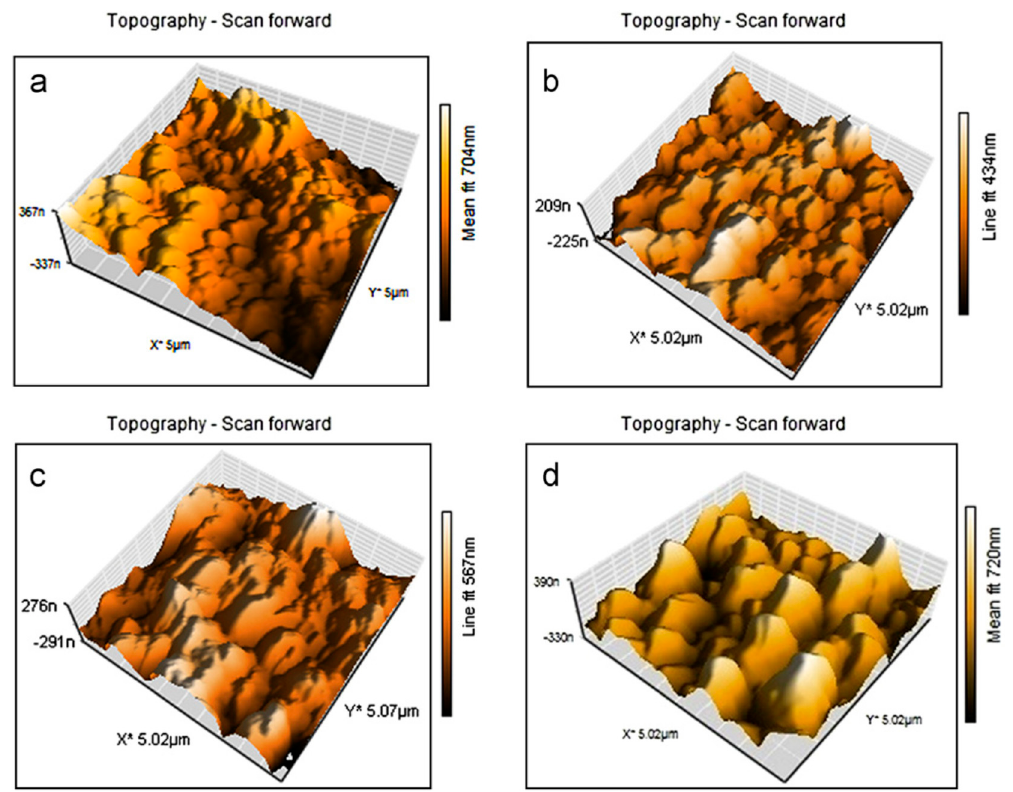
Figure 4. Atomic force microscopy (AFM) analyses of ( a ) thin film composite (TFC), ( b ) thin-film nanocomposite membrane (TFN) 0.01, ( c ) TFN 0.05 and ( d ) TFN 0.1 membranes. (Reproduced with permission after [33]).